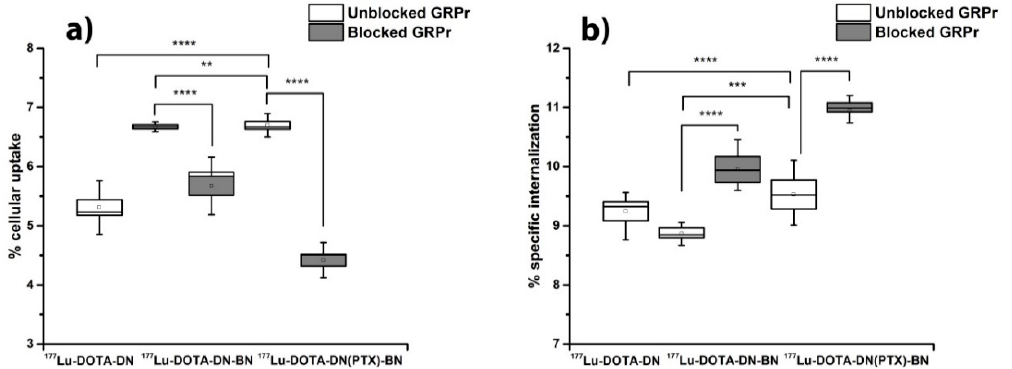
Figure 5. Uptake ( a ) and internalization ( b ) of 177 Lu-DOTA-DN, 177 Lu-DOTA-DN-BN, and 177 Lu-DOTA-DN(PTX)-BN in T47D cells (vacuum boxes). Cells with blocked receptors were pre-incubated with excess (500 times) of Bombesin peptide (full boxes) to determine specific uptake. Whisker represents SD (n = 6).